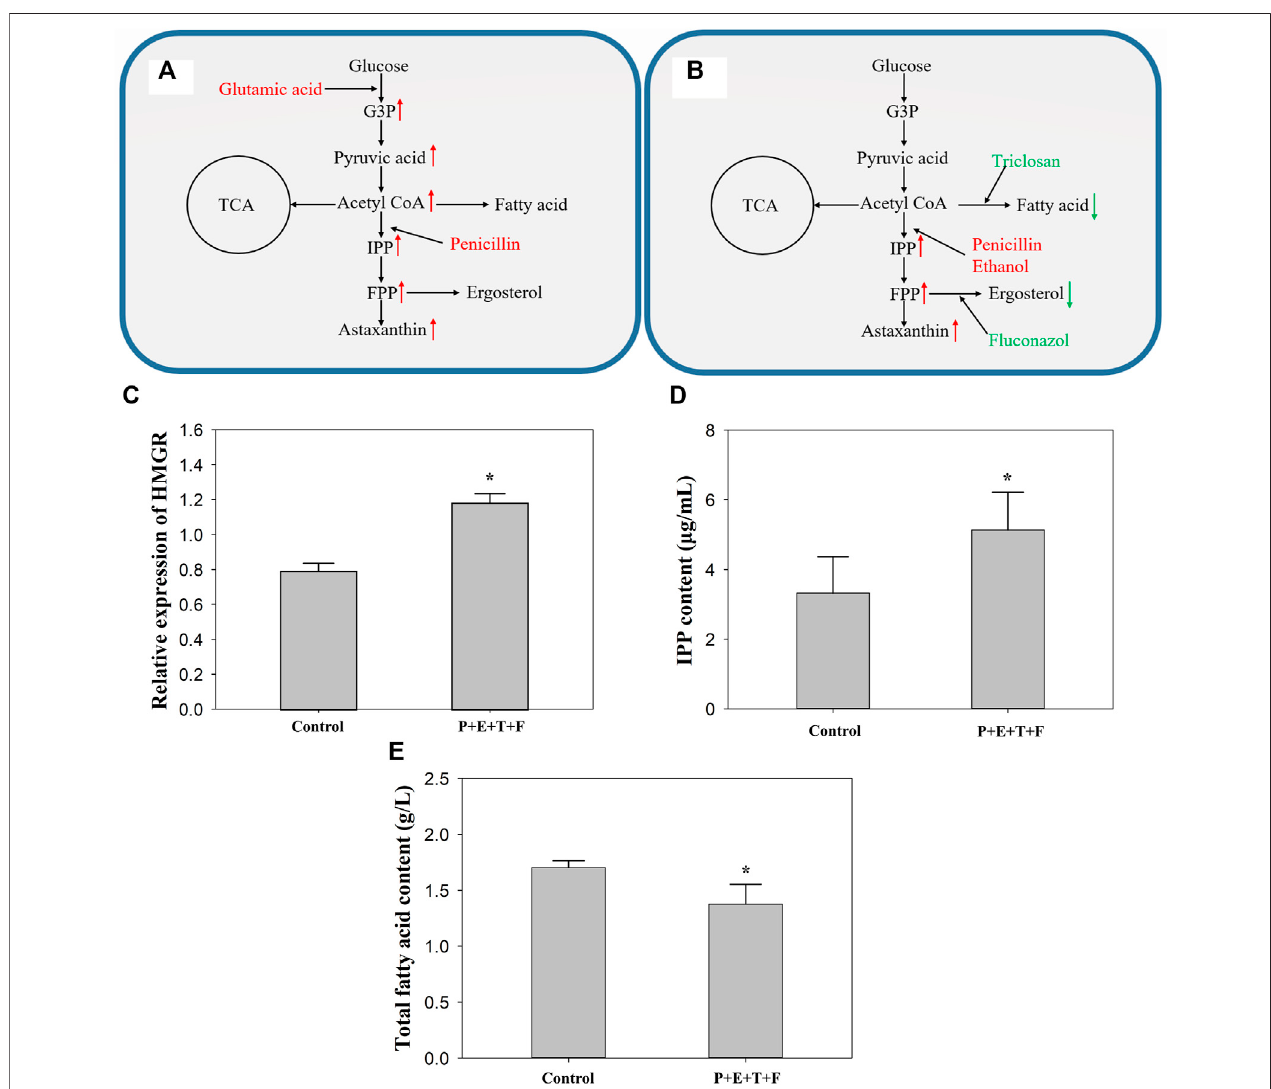
FIGURE 4 | The effect of different regulator combinations on the metabolic pathway in P. rhodozyma MVP14. (A) Highest astaxanthin volumetric yield with adding glutamicacidandpenicillin. (B) Highest astaxanthin cellyieldwithadding penicillin,ethanol,triclosan and fl uconazol. Redsubstancerepresentsthepromotion ofcurrent pathway, while green substance represents the inhibition. Changes in the relative expression of HMGR gene (C) , IPP content (D) and total fatty acids (E) after adding penicillin, ethanol, triclosan and fl uconazol to P. rhodozyma MVP14. The red arrow indicates that the metabolite is increased, and the green one indicates that it is decreased. G3P: glucose-3-phosphate, IPP: isopentenyl pyrophosphate, FPP: farnesyl pyrophosphate, TCA: tricarboxylic acid cycle, P: penicillin, E: ethanol, T: triclosan, F: fl uconazol. (* signi fi cantly different from control, p < 0.05).